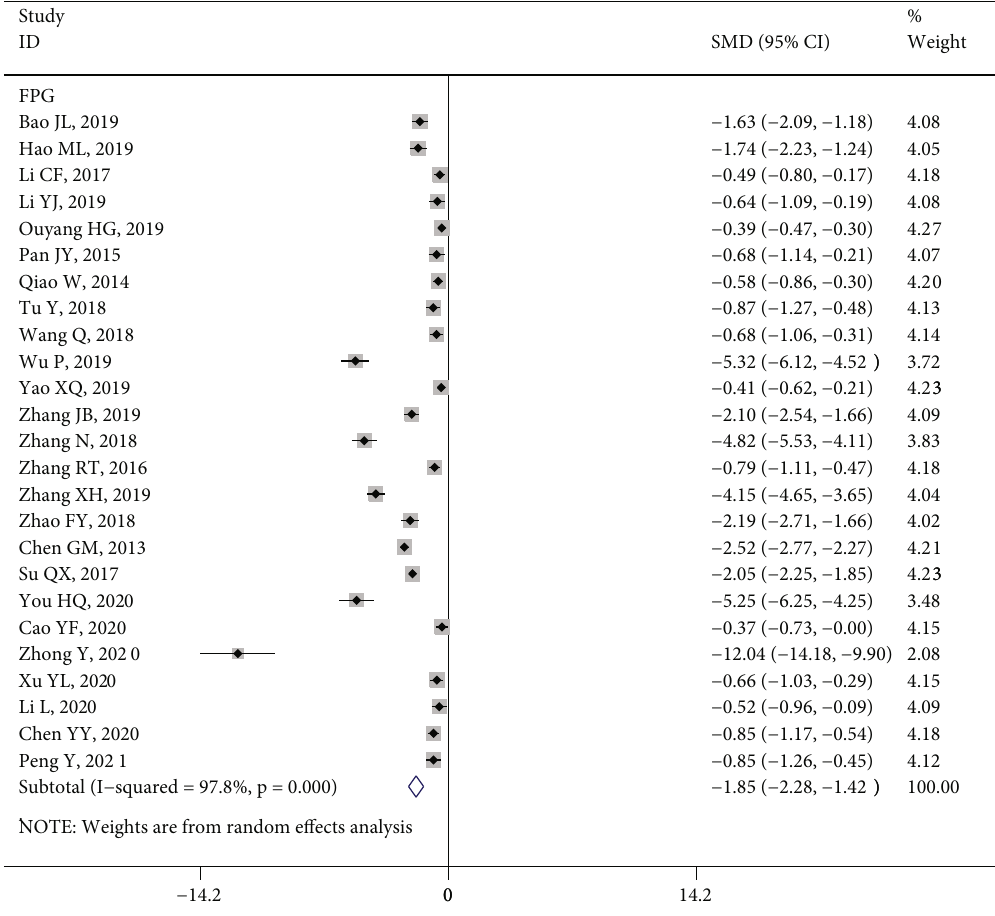
e ff ect of HL intervention on 2hPG levels, showing a signi fi - cant improvement in 2hPG in the intervention group com- pared with the control group ( SMD = − 2 : 18 , 95% CI ( − 2.68, − 1.68), P < 0 : 05 ; Q statistic, I 2 = 96 : 7 % , P < 0 : 1 ) (Figure 3). However, a subgroup analysis of two non-RCT studies [16, 53] showed that the HL interventions failed to signi fi cantly improve the 2hPG levels of patients, as shown in Figure S3.